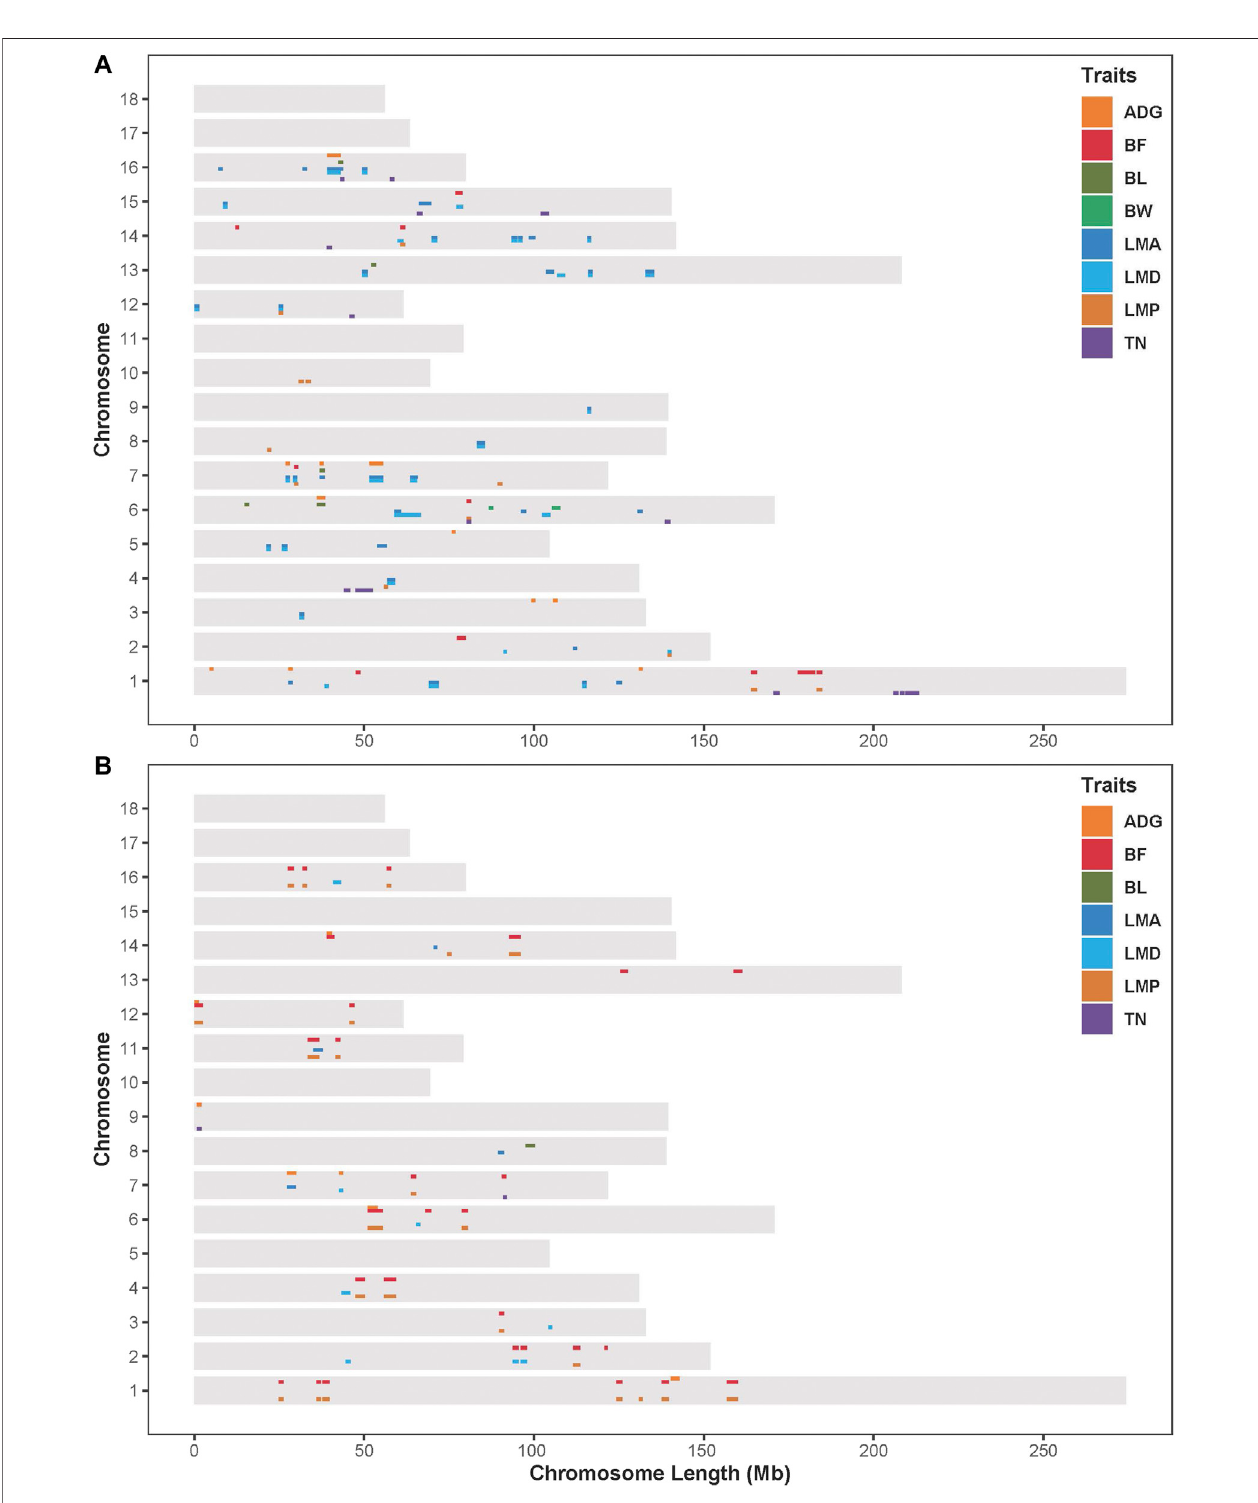
FIGURE 4 | Distribution of signi fi cant ROHets in genome-wide ROHet analysis. (A) The S21 population. (B) The S22 population. ADG, 100 kg average daily gain; BF,100 kgbackfatthickness;BL,bodylength;BW,birthweight;LMA,loinmusclearea;LMD,loinmuscledepth;LMP,leanmeatpercentage;andTN,totalteatnumber.